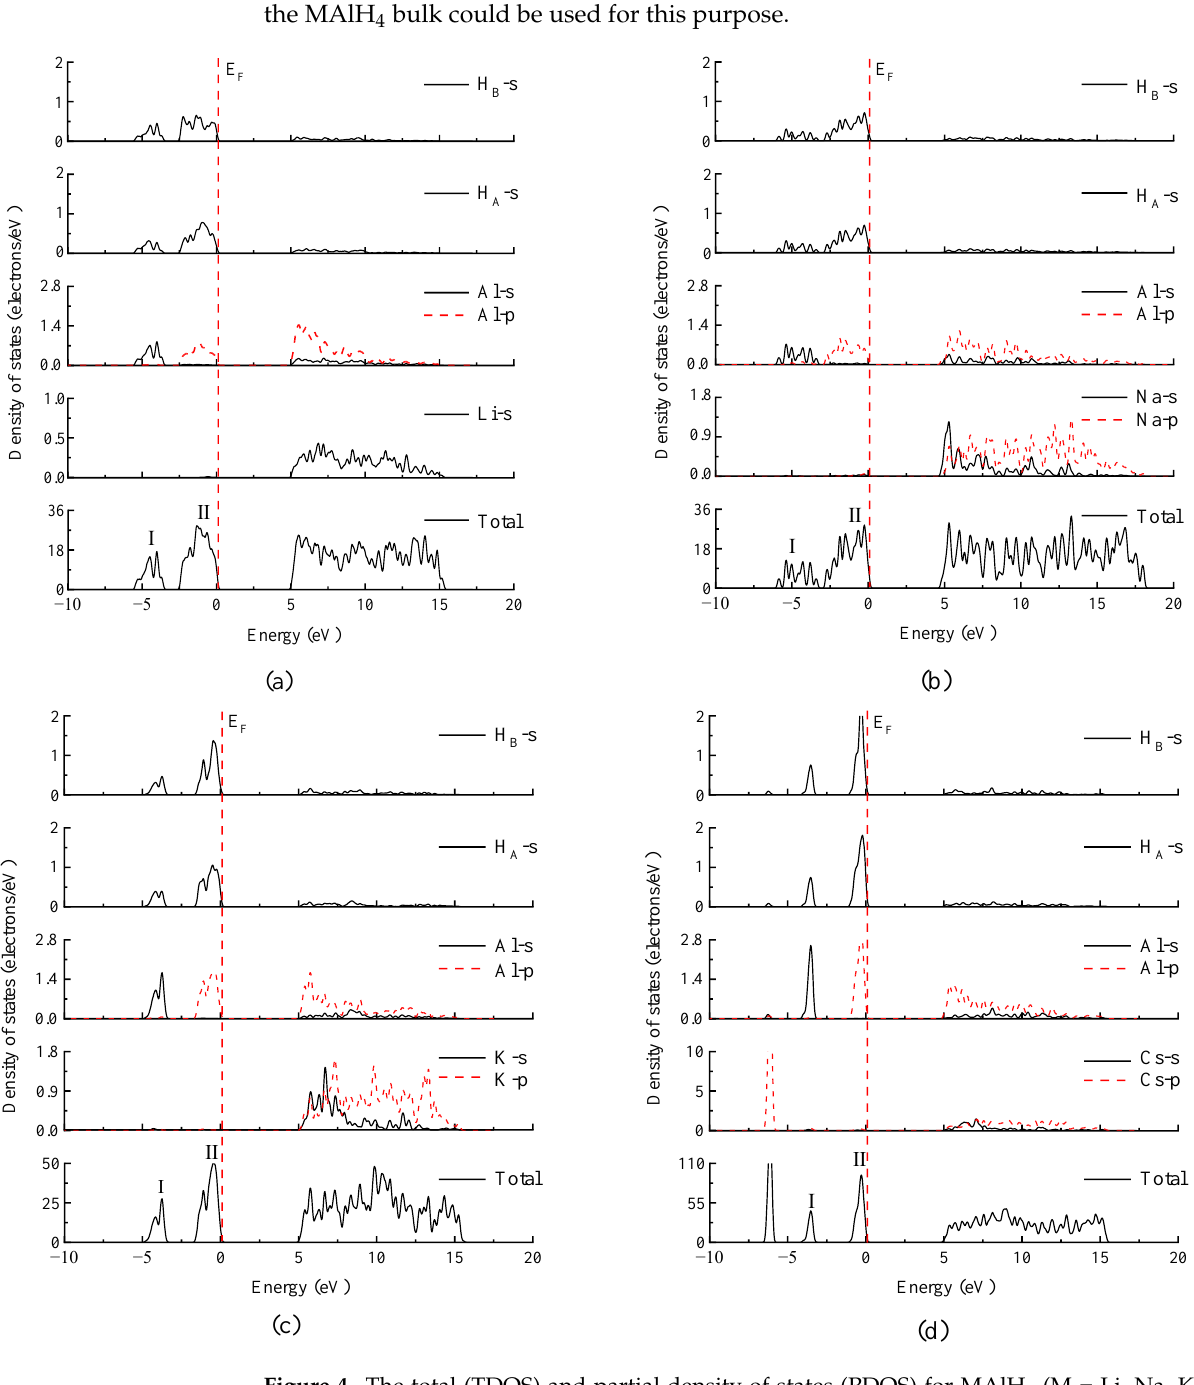
Figure 4. The total (TDOS) and partial density of states (PDOS) for MAlH 4 (M = Li, Na, K, and Cs), with Fermi level (E F , marked with vertical dotted line) at 0 eV and H atoms (H A and H B ) from considered [AlH 4 ] unit in Figure 1: ( a ) LiAlH 4 , ( b ) NaAlH 4 , ( c ) KAlH 4 , and ( d ) CsAlH 4 . The TDOS labeled by I and II are mainly contributed by Al and H electronic states.